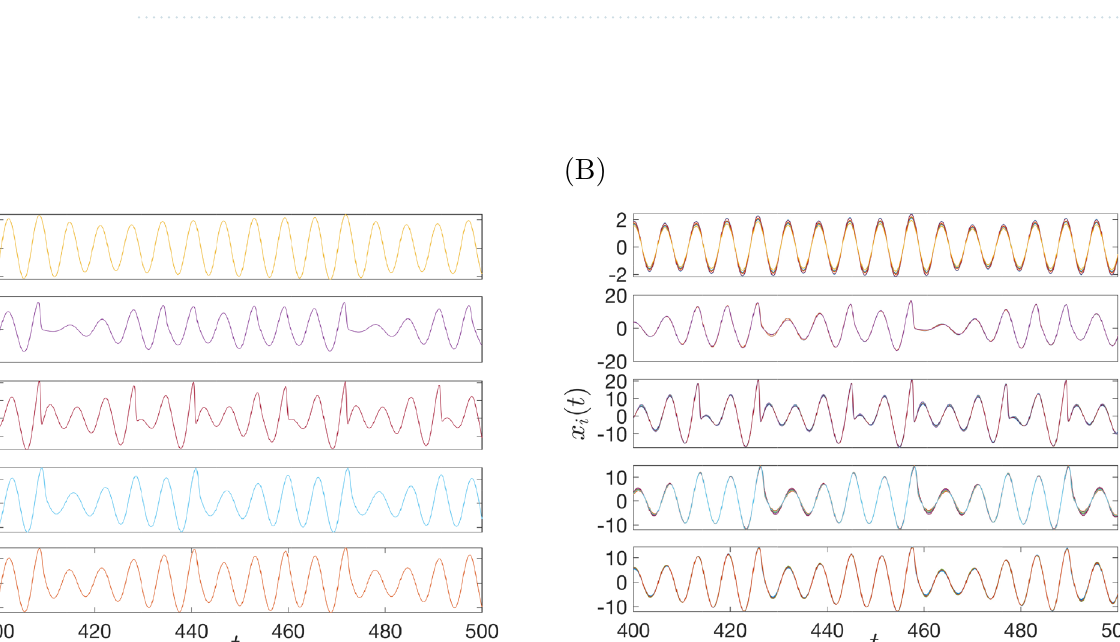
Figure 2. Correction cost for a synthetic network with N = 50 nodes. ( A ) Structure of the network. In the absence of perturbations this network has k ∗ = 5 true clusters (dashed lines in panels B and C). Nodes are colored differently according to the true cluster to which they belong. ( B ) Correction cost ψ versus k for two magnitudes of perturbation. ( C ) Correction cost ˆ ψ versus k for two magnitudes of perturbation. ( D – F ) Consensus dynamics as described in Eq. (9) with a type I perturbation with respective magnitudes ǫ = 0 , ǫ = 10 − 1 , and ǫ = 10 0 .